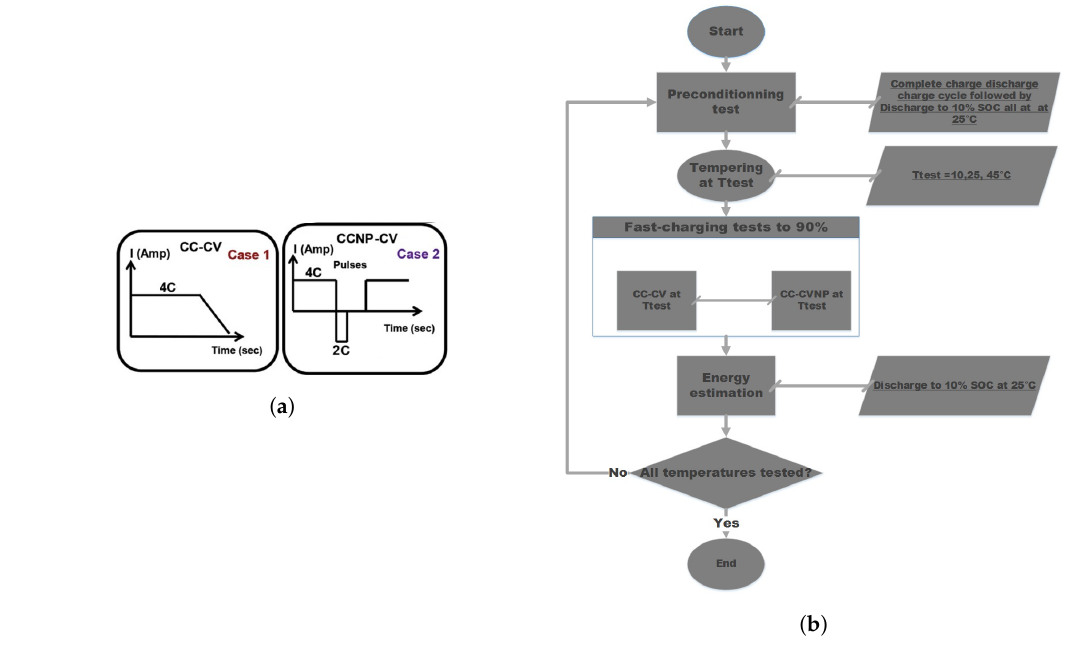
Figure 2. ( a ) Fast-charging profiles, where Case 1 shows a constant current–constant voltage (CC–CV) profile, and Case 2 shows a constant current with negative pulse–constant voltage (CCNP–CV) profile; ( b ) Charging protocol flowchart